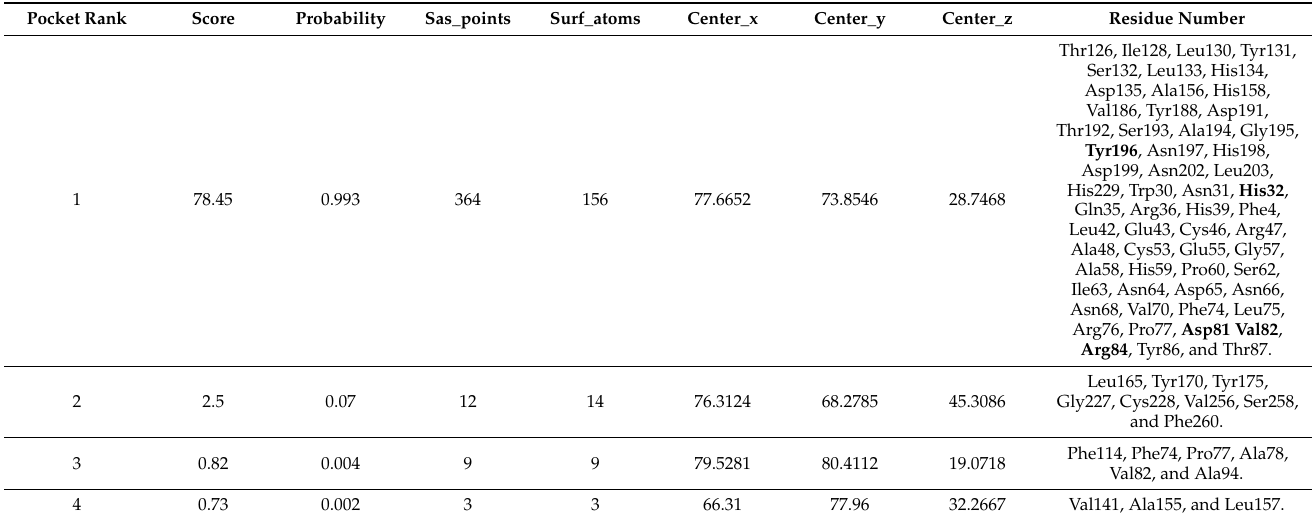
Table 1. Prediction of ligand binding site in HEV-MTase refined model structure using Prank Web server. The invariant tyrosine, histidine, and DXXR Motif residues are represented in bold residues numbers in the HEV-MTase